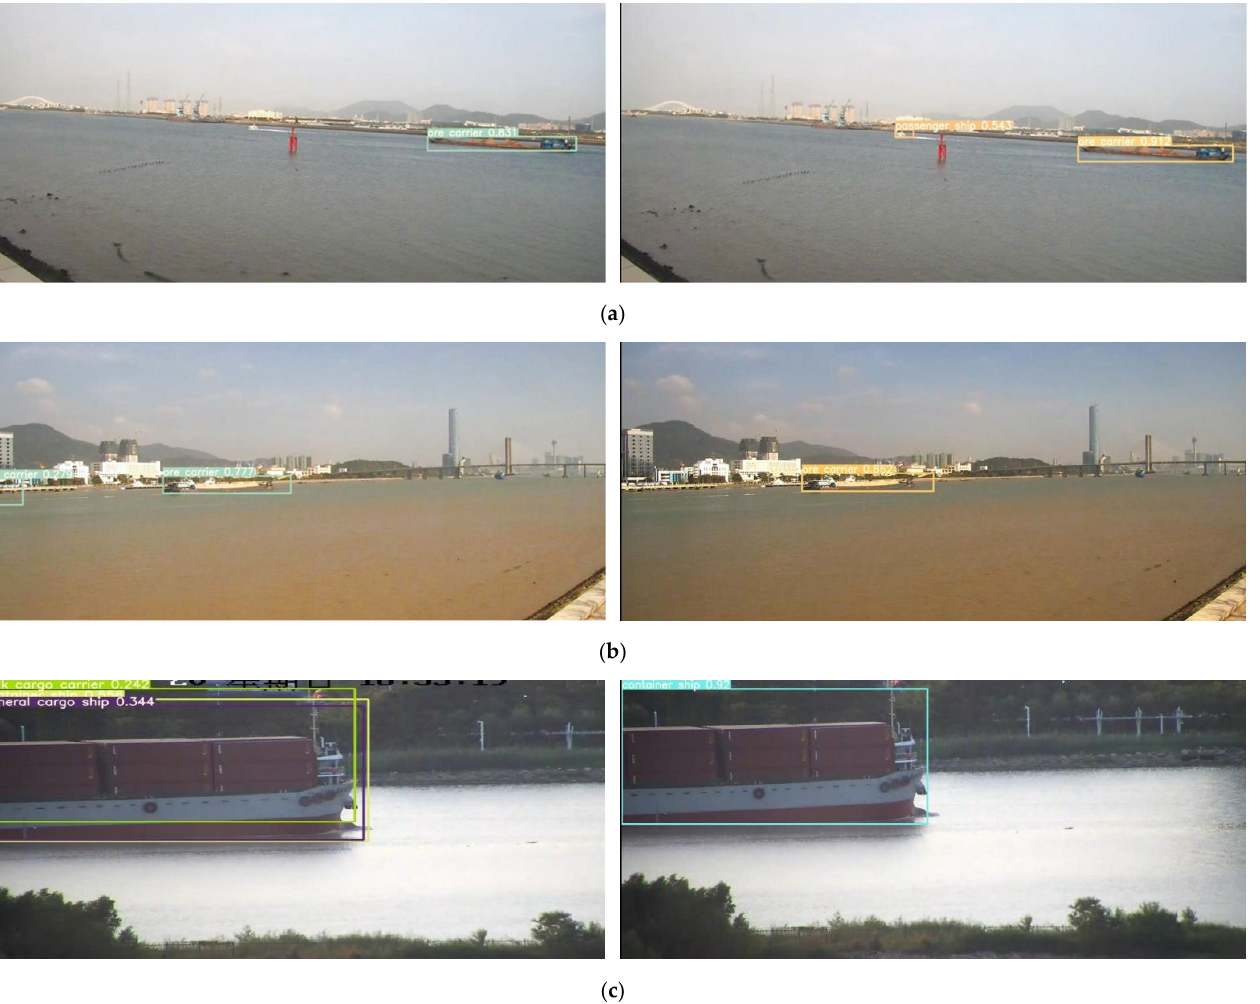
Figure 11. ( a ) Missed identification improvement; ( b ) misunderstanding improvement; ( c ) forecast improvement. The original algorithm of Figure 11b misidentified the distant shore as an ore